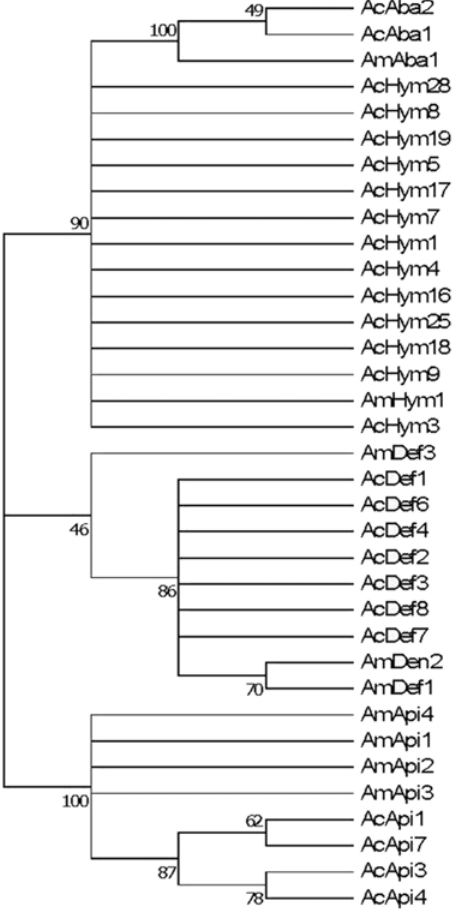
Figure 6. Neighbor-Joining (NJ) tree of four antimicrobial peptide cDNA gene families of A.cerana and A.mellifera . All the cDNA sequences for A. cerana were edited to begin at the initiation codon and end at the stop codon (containing complete cds). All the cDNA sequences for A. mellifera are downloaded from the NCBI website and edited to end in the stop codon (containing complete or partial cds). Numbers at nodes are bootstrap values based on 1000 replications. The cDNA gene names, GenBank accession numbers and the encoding peptide names are listed in Table 1.